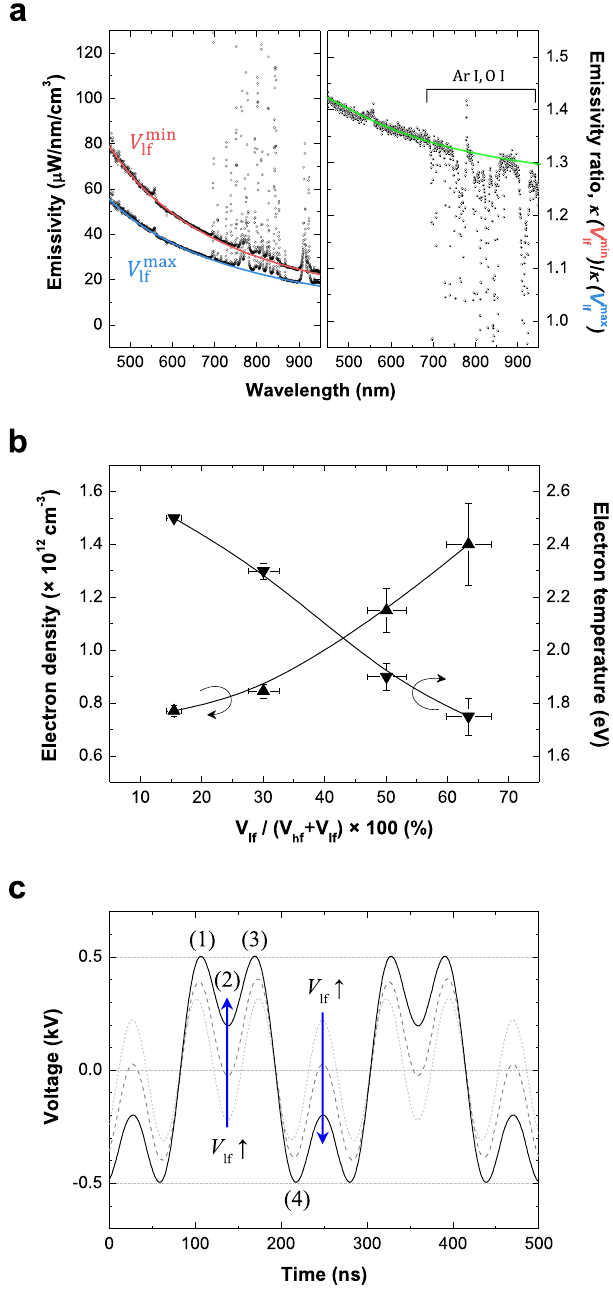
Figure 3. Electron information in dual-rf argon capacitive discharges. ( a ) Measured emission spectra (black scatters) with the theoretically calculated κ ea (red and blue lines) in the left panel, and the emissivity ratio of the measurement (black) and calculation (green) in the right panel. ( b ) Electron density and temperature as a function of the percentage of the V lf component. ( c ) Dual-frequency voltage waveforms at different V lf . Data in b are shown as the mean ± s.d.; n = 5. The error bar of the x -axis data corresponds to the difference between the input rf power and the dissipated rf power or